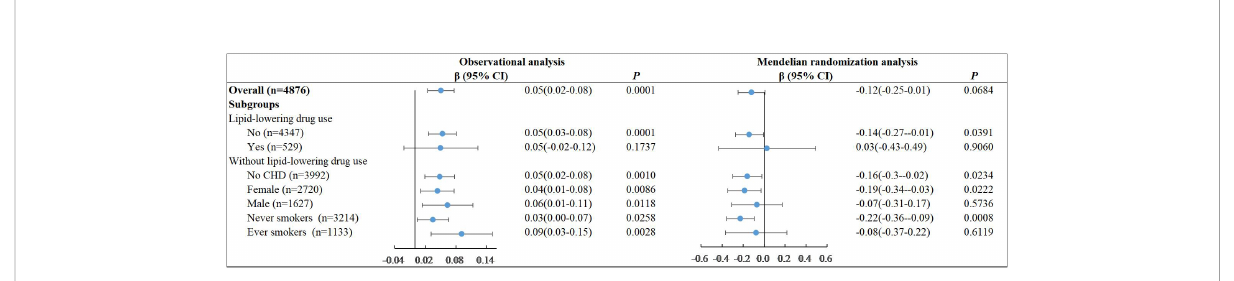
FIGURE 3 Linear associations of LDL-C and FBG in observational analysis and MR